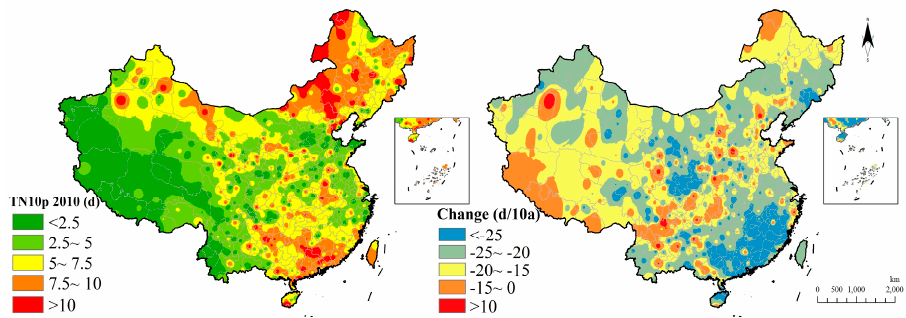
Figure 10. Cool nights indicator distribution and change.